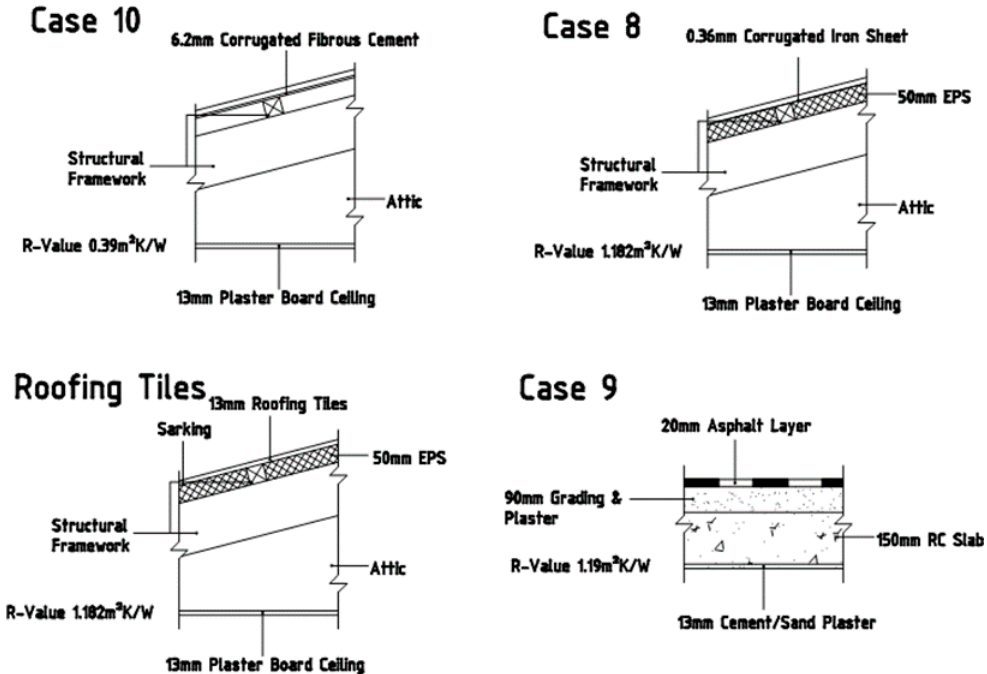
Figure A4. Roof envelope configuration.